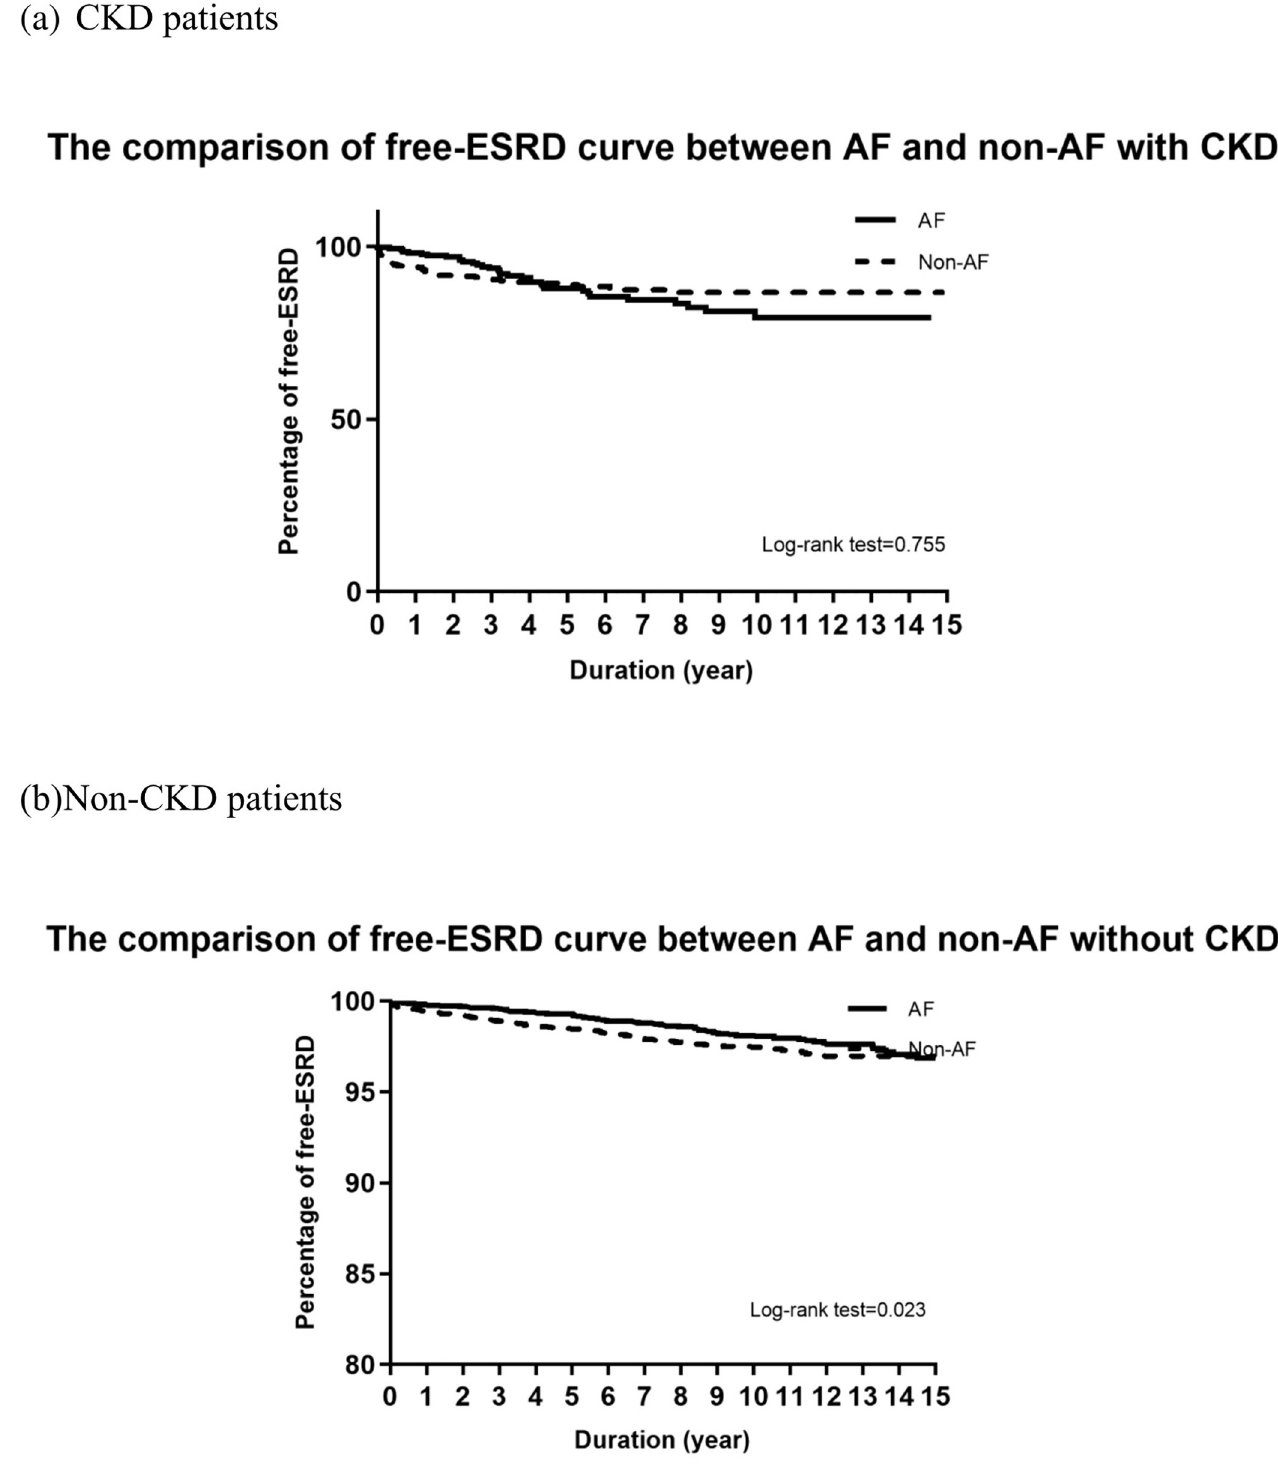
Fig 2. Comparison of the end-stage renal disease curve between patients with diabetes with and without AF.